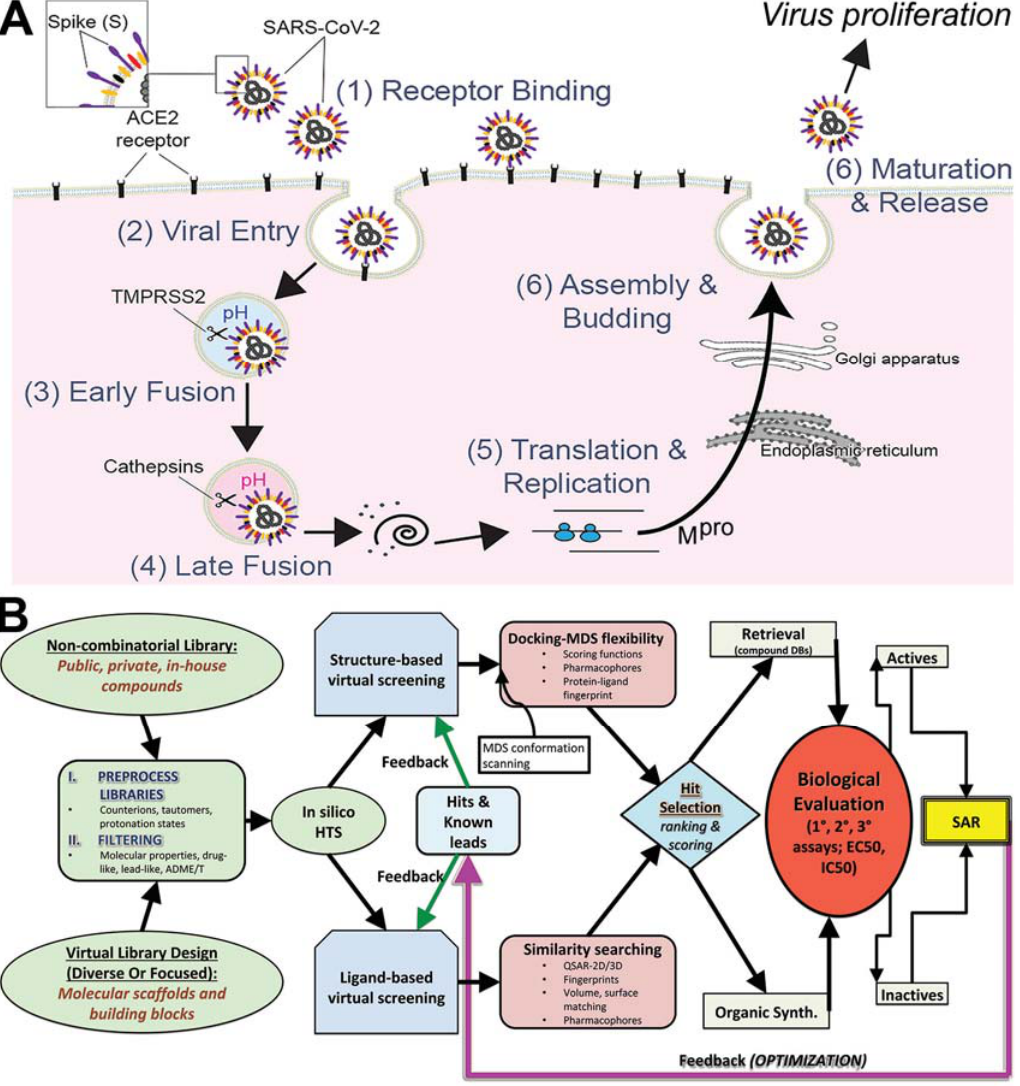
Figure 1. Flowchart for drug pipeline for attacking COVID ‐ 19 via a polypharma small ‐ molecule approach using in silico screening and advanced simulation biasing. ( A ) Biological infection of SARS ‐ CoV ‐ 2 from initial binding, entry and replication to virus proliferation. ( B ) Overview of COVID ‐ 19 Drug Discovery Pipeline.